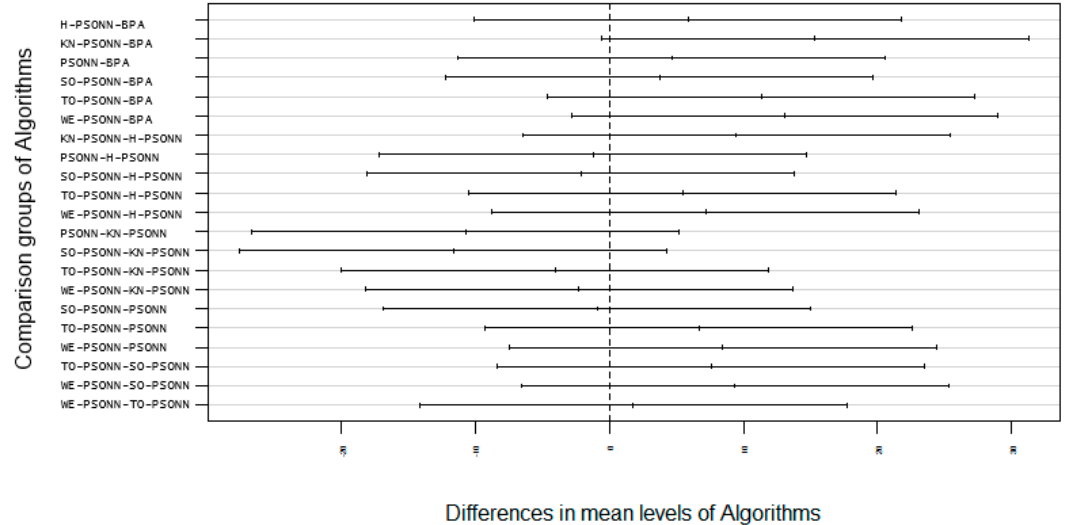
Figure 41. Multicomparison post hoc Tukey test graph of all PSO-based initialization approaches and BPA.